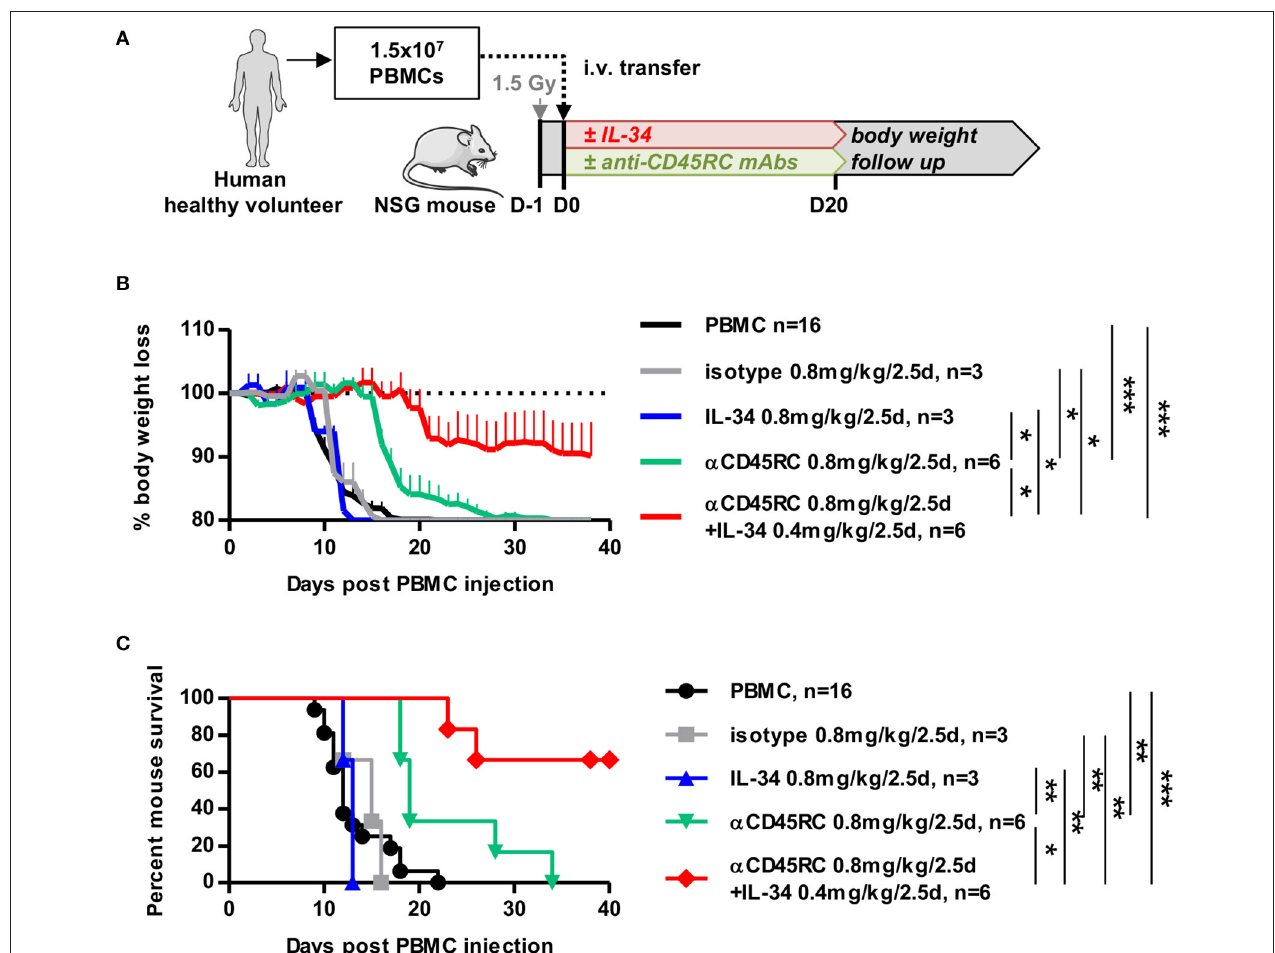
FIGURE 4 | IL-34 in combination with depletion of naive cells prolongs survival in an acute GVHD humanized model. (A) Schematic depicting the GVHD model in humanized mice. NSG mice were injected with human PBMCs, treated or not with IL-34 protein and/or anti-CD45RC mAbs for 20 days, and followed for body weight loss. (B) Evolution of mouse body weight over time, normalized to the weight before the injection of PBMCs (D0), after no treatment (black line), IL-34 treatment (blue line), anti-CD45RC mAb treatment (green line), isotype Ig control treatment (gray line), and dual IL-34 + anti-CD45RC mAb treatment (red line). n = 3–16. Mean ± SEM is represented. Two Way repeated measure ANOVA, * p < 0.05, *** p < 0.001. (C) Percentage of mouse survival over time. n = 3–16. Log Rank (Mantel-Cox) test, * p < 0.05, ** p < 0.01, *** p <